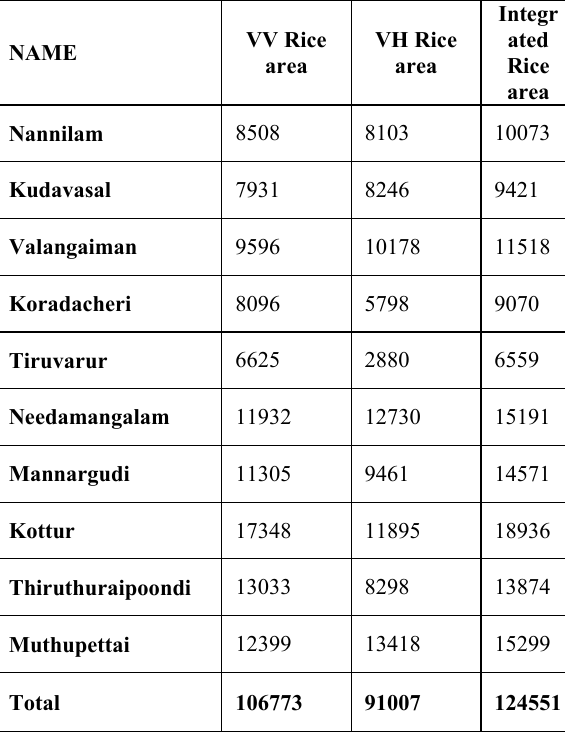
Table.5 Comparison of block wise rice area derived from VV, VH and integrated VV-VH Polarization for Tiruvarur district